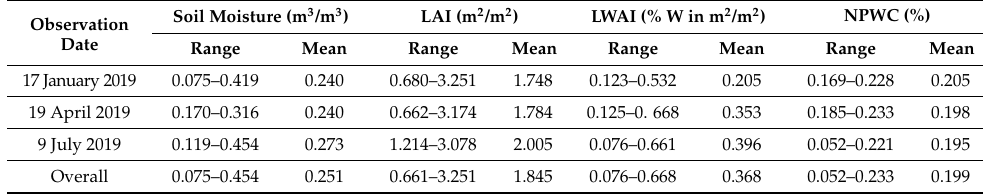
Table 3. Summary of in-situ data collection of Soil Moisture, LAI, LWAI and NPWC.